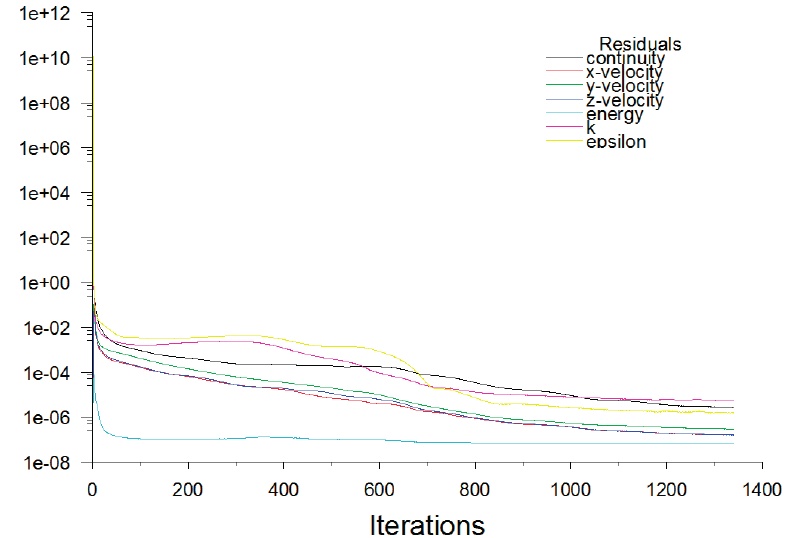
Figure 8. CFD solution residuals.